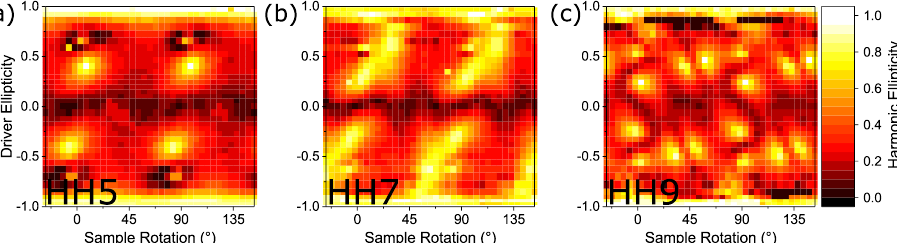
Figure 1: High-harmonic ellipticities versus driver pulse ellipticity and sample rotation for HH5 (a), HH7 (b) and HH9 (c). 0° sample rotation corresponds to driver major axis along (100)-direction, while 45° refers to